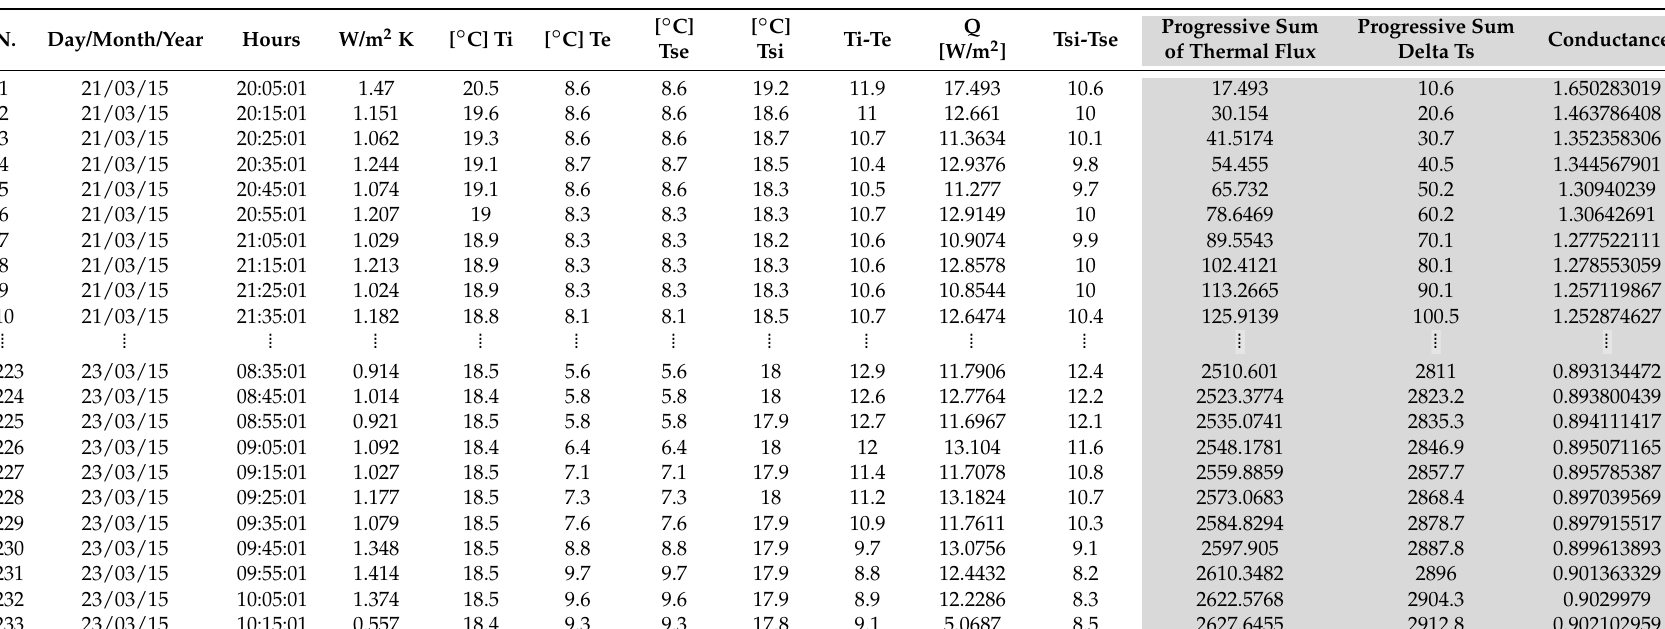
Table 3. On the left side, the data detected by the thermal flux meter. Tabular output. In particular, in the table there are data concerning the first and the last Table 2. On the left side, the data detected by the thermal flux meter Tabular output. In particular, in the table there are data concerning the first and the last 10 Table 2. On the left side, the data detected by the thermal flux meter Tabular output. In particular, in the table there are data concerning the first and the last 10 Table 2. On the left side, the data detected by the thermal flux meter Tabular output. In particular, in the table there are data concerning the first and the last 10 Table 2. On the left side, the data detected by the thermal flux meter Tabular output. In particular, in the table there are data concerning the first and the last 10 Table 2. On the left side, the data detected by the thermal flux meter Tabular output. In particular, in the table there are data concerning the first and the last 10 Table 2. On the left side, the data detected by the thermal flux meter Tabular output. In particular, in the table there are data concerning the first and the last 10 Table 2. On the left side, the data detected by the thermal flux meter Tabular output. In particular, in the table there are data concerning the first and the last 10 Table 2. On the left side, the data detected by the thermal flux meter Tabular output. In particular, in the table there are data concerning the first and the last 10 Table 2. On the left side, the data detected by the thermal flux meter Tabular output. In particular, in the table there are data concerning the first and the last 10 Table 2. On the left side, the data detected by the thermal flux meter Tabular output. In particular, in the table there are data concerning the first and the last 10 Table 2. On the left side, the data detected by the thermal flux meter Tabular output. In particular, in the table there are data concerning the first and the last 10 Table 2. On the left side, the data detected by the thermal flux meter Tabular output. In particular, in the table there are data concerning the first and the last 10 Table 2. On the left side, the data detected by the thermal flux meter Tabular output. In particular, in the table there are data concerning the first and the last 10 Table 2. On the left side, the data detected by the thermal flux meter Tabular output. In particular, in the table there are data concerning the first and the last 10 10 measurements, so as to highlight the variation of the parameters involved in the measurement. The data for the last four cycles mentioned in the text can be seen. measurements, so as to highlight the variation of the parameters involved in the measurement. On the right side, against the grey background, the calculation of the measurements, so as to highlight the variation of the parameters involved in the measurement. On the right side, against the grey background, the calculation of the measurements, so as to highlight the variation of the parameters involved in the measurement. On the right side, against the grey background, the calculation of the measurements, so as to highlight the variation of the parameters involved in the measurement. On the right side, against the grey background, the calculation of the measurements, so as to highlight the variation of the parameters involved in the measurement. On the right side, against the grey background, the calculation of the measurements, so as to highlight the variation of the parameters involved in the measurement. On the right side, against the grey background, the calculation of the measurements, so as to highlight the variation of the parameters involved in the measurement. On the right side, against the grey background, the calculation of the measurements, so as to highlight the variation of the parameters involved in the measurement. On the right side, against the grey background, the calculation of the measurements, so as to highlight the variation of the parameters involved in the measurement. On the right side, against the grey background, the calculation of the measurements, so as to highlight the variation of the parameters involved in the measurement. On the right side, against the grey background, the calculation of the measurements, so as to highlight the variation of the parameters involved in the measurement. On the right side, against the grey background, the calculation of the measurements, so as to highlight the variation of the parameters involved in the measurement. On the right side, against the grey background, the calculation of the measurements, so as to highlight the variation of the parameters involved in the measurement. On the right side, against the grey background, the calculation of the measurements, so as to highlight the variation of the parameters involved in the measurement. On the right side, against the grey background, the calculation of the On the right side, against the grey background, the calculation of the variables of the Equation (1) has been inserted. variables of the Equation (1) has been inserted. variables of the Equation (1) has been inserted. variables of the Equation (1) has been variables of the Equation (1) has been inserted. variables of the Equation (1) has been inserted. variables of the Equation (1) has been inserted. variables of the Equation (1) has been inserted. variables of the Equation (1) has been inserted. variables of the Equation (1) has been inserted. variables of the Equation (1) has been inserted. variables of the Equation (1) has been inserted. variables of the Equation (1) has been inserted. variables of the Equation (1) has been inserted. variables of the Equation (1) has been inserted. N. Hours W/m 2 K [ ◦ C] Ti